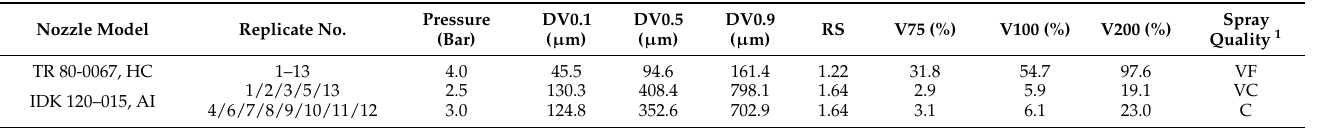
Table 2. Droplet size spectrum and spray quality classification of the hollow cone nozzle and the air induction nozzle used in